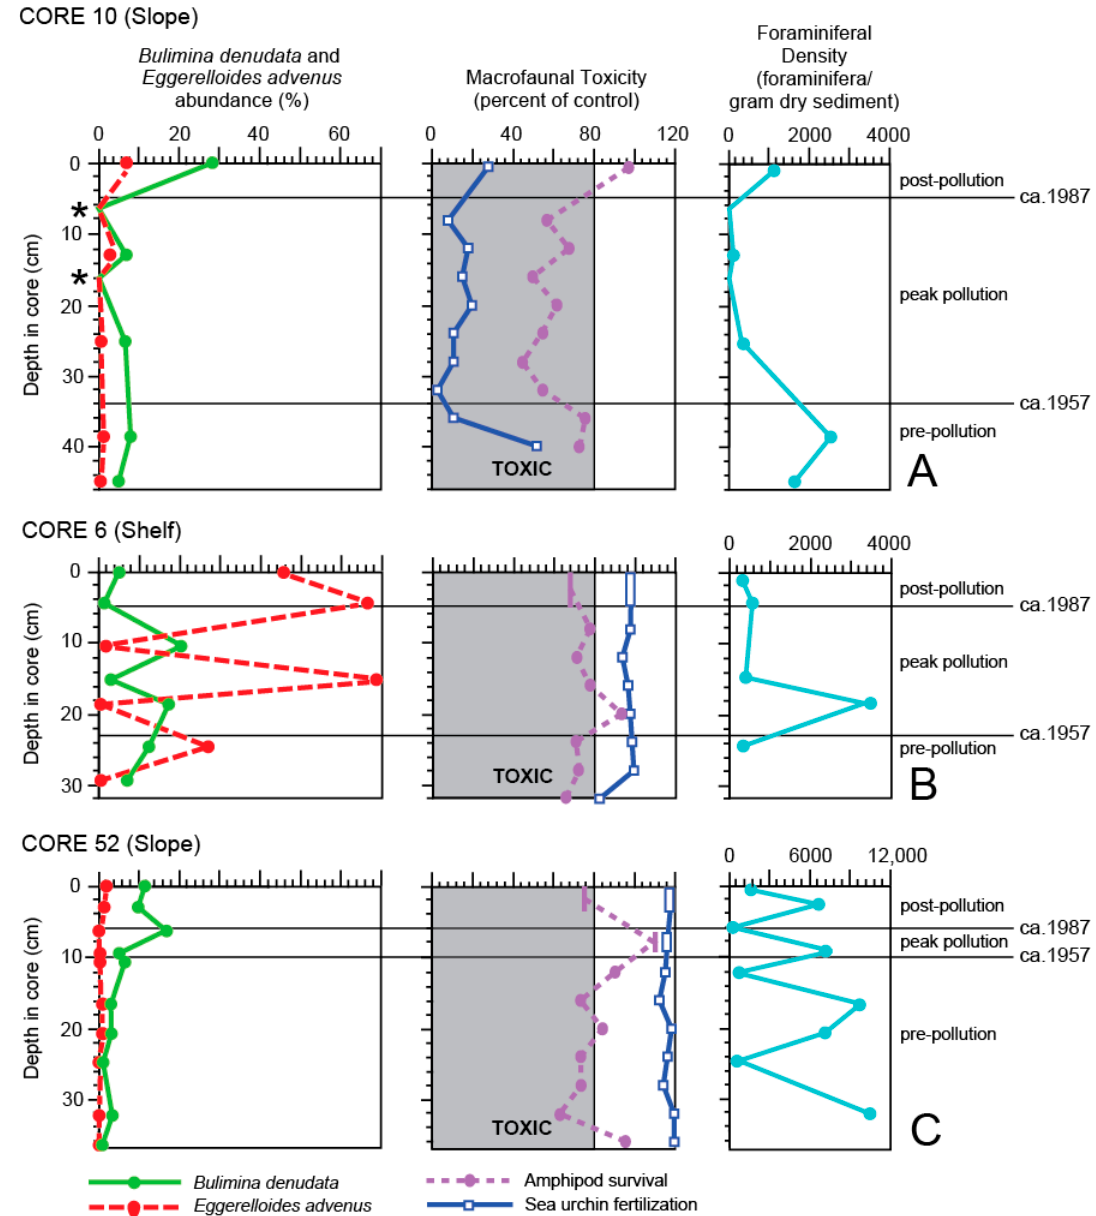
Figure 7. Relative abundances (percent) of foraminifers Bulimina denudata and Eggerelloides advenus , macrofaunal toxicity (amphipod survival and sea urchin fertilization), and Foraminiferal Density (number of foraminifera/gram dry sediment) with depth in core. Toxicity data as percent of control and midpoint of data range plotted. Five cores have composite toxicity data for the uppermost samples (0–3.5 or 0–5 cm) and are plotted as vertical bars. Samples with <80% of controls surviving were considered toxic and are highlighted in gray. Note the change in scale on the Foraminiferal Density plots. Plots ( A – C ) correspond to Cores 10, 6, 52, respectively. Core 6 was obtained on the shelf, and Cores 10 and 52 were obtained on the slope. Samples with extremely rare foraminifera (Core 10) are indicated by an asterisk. Plots ( D – G ) correspond to Cores 36, 20, 24, and 34, respectively. Cores 36 and 24 were obtained on the slope, and Cores 20 and 34 were obtained on the